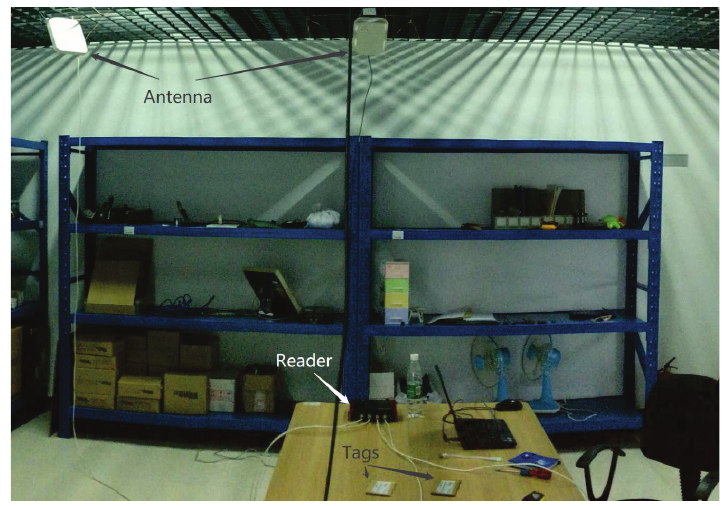
Figure 8. Experimental Setup in Realistic Environment.